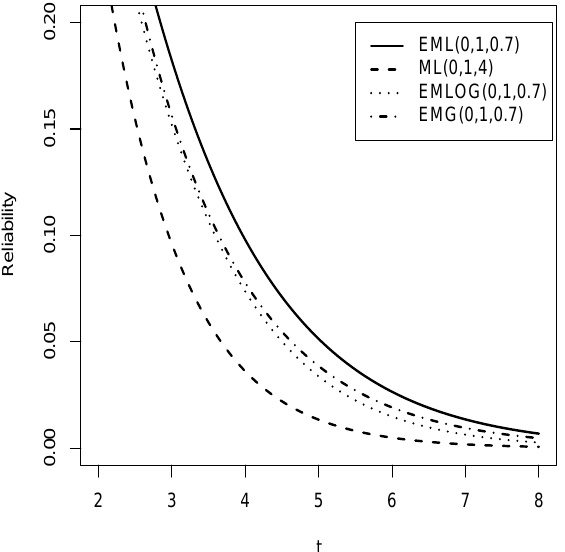
Figure 3. Comparison of the reliability function of the EML distribution (solid line) for λ = 0.7 with the reliability function of the ML , EMLOG , and EMG distributions (dashed line, dotted line, dash-dotted